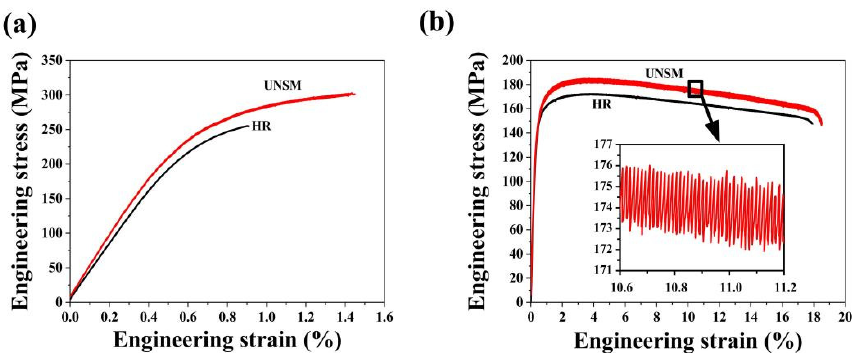
Figure 8. Engineering stress-strain curves of LAE361 Mg-Li alloy ( a ) and LA106 Mg-Li alloy ( b ) before Figure 8. Microhardness distribution of the cross-sections of LAE361 Mg-Li alloy ( a ) and LA106 Mg- Li alloy ( b ) before and after UNSM treatment. and after UNSM treatment.